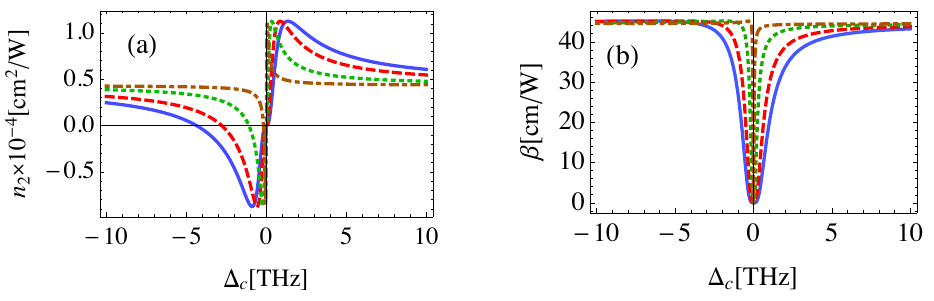
Figure 8. The self-Kerr nonlinear index of refraction ( a ) and nonlinear absorption coefficient ( b ) in the MNP-GND-QD hybrid system of R GM = 26 nm, θ M = 0.5 rad, θ G = 1 rad, R M = 15 nm excited with resonant probe field and control field of Ω c = 100 GHz (solid), Ω c = 80 GHz (dashed), Ω c = 50 GHz (dotted) and Ω c = 20 GHz (dashed-dotted).